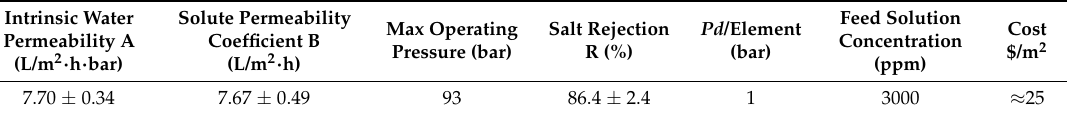
Table 3. Selected membrane properties [15].